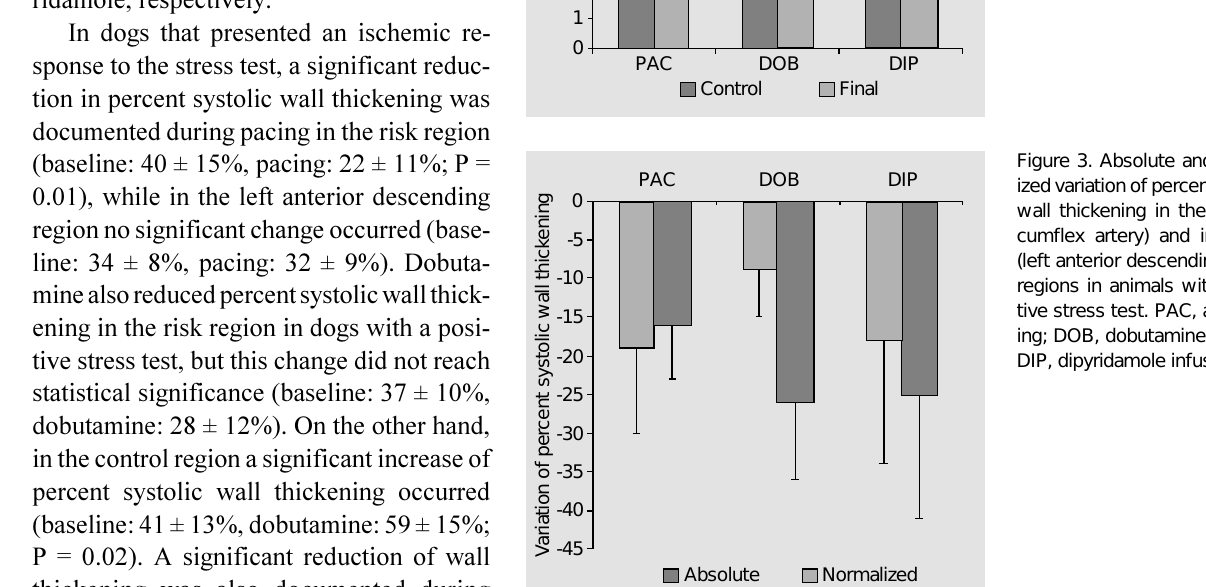
Figure 3. Absolute and normal- ized variation of percent systolic wall thickening in the risk (cir- cumflex artery) and in control (left anterior descending artery) regions in animals with a posi- tive stress test. PAC, atrial pac- ing; DOB, dobutamine infusion; DIP, dipyridamole